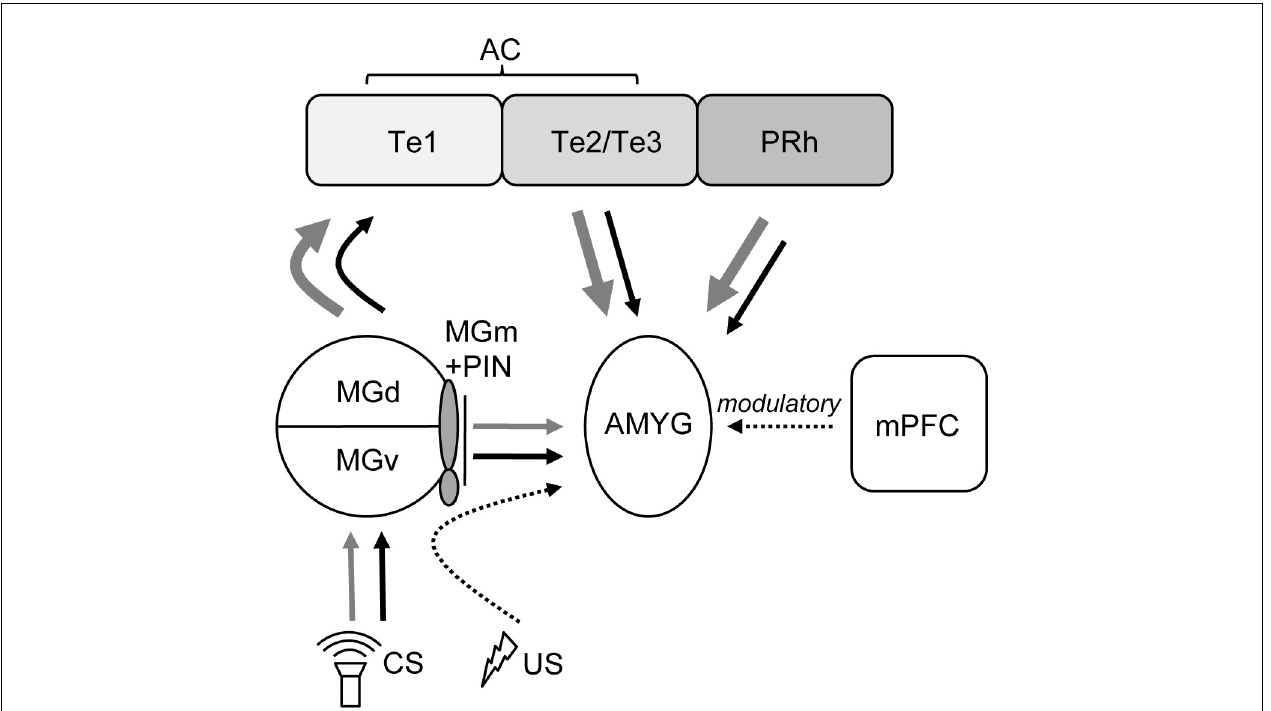
FIGURE 5 | Depiction of auditory afferent projections to the amygdala originating from auditory thalamus and cortex (modifi ed from Campeau and Davis, 1995; Boatman and Kim, 2006). For both TONE - ON (black lines) and TONE - OFF (gray lines) CSs, the default (1 ° ) and secondary (2 ° ) pathways supporting fear conditioning and extinction involves the AC and the MGm/ PIN, respectively, to the AMYG. The mPFC exerts modulatory